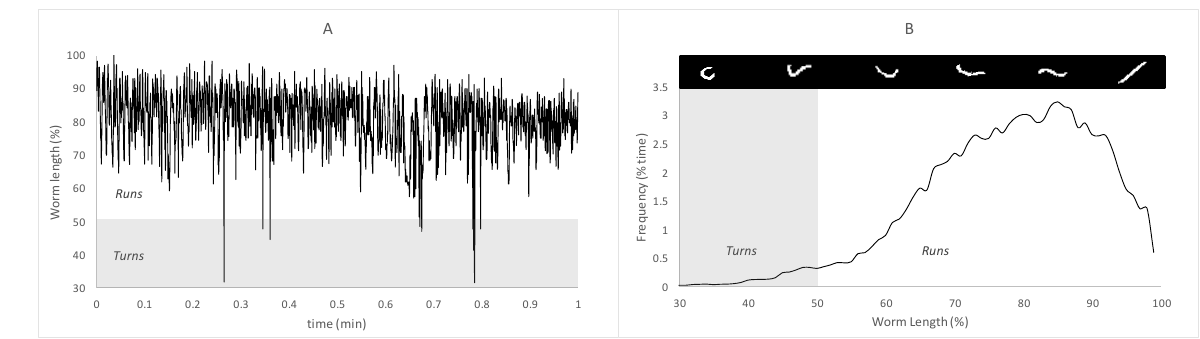
Figure 1. Data transformation from Block B. ( A ): raw time series of % worm length; ( B ): histogram of Figure 1. Gray and white zones indicate the turns and runs zones of the spectrum, respectively.